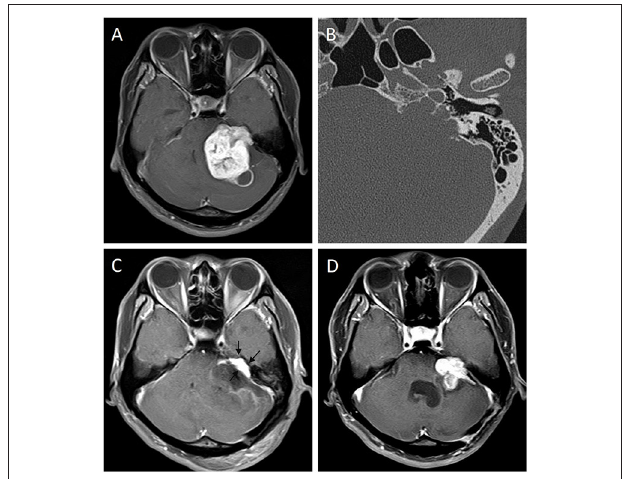
FIGURE 3 | Progression of a remnant vestibular schwannoma with irregular IAC. Preoperative enhanced MRI (A) of a 29-year-old man showed a giant VS of left side. Thin-slice CT bone window image of temporal bone (B) showed irregular IAC type. Three-month postoperative enhanced MRI (C) showed remnant tumor located in the IAC (arrows). The tumor had progression 3 months later (D)